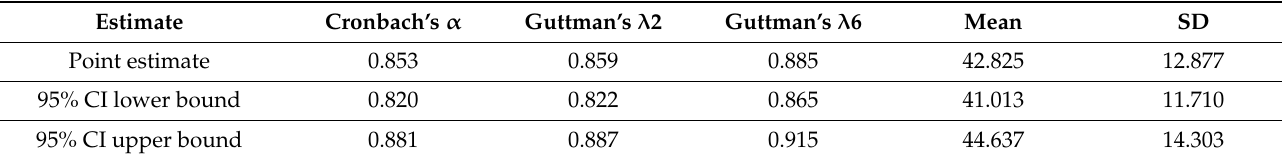
Table 7. Frequentist scale reliability statistics.